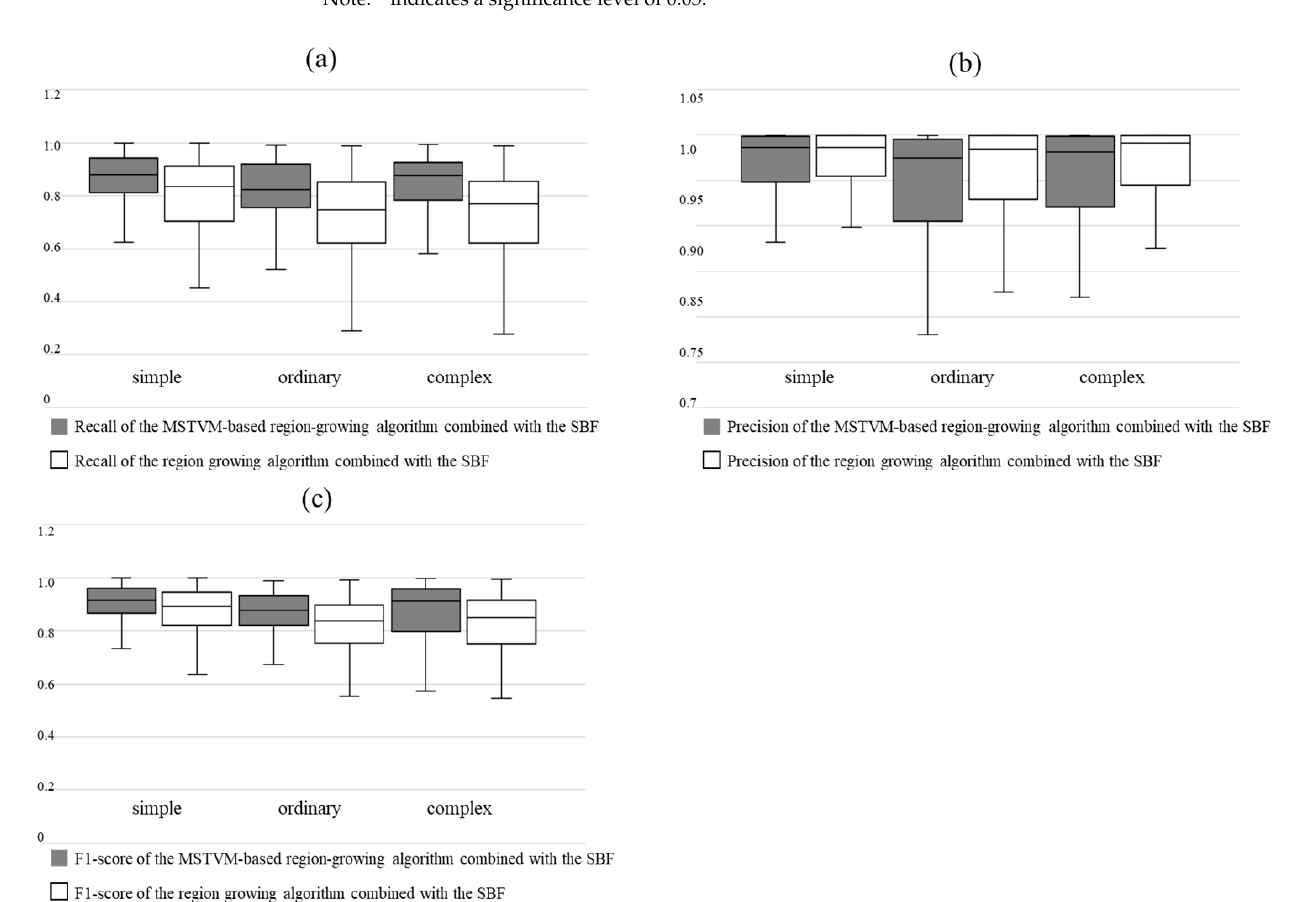
Figure 10. Box plots of the accuracy indicators between the MSTVM-based region-growing algorithm combined with SBF and by the region-growing algorithm combined with SBF: ( a ) are the recall; ( b ) are the precision; ( c ) are the f1-score.